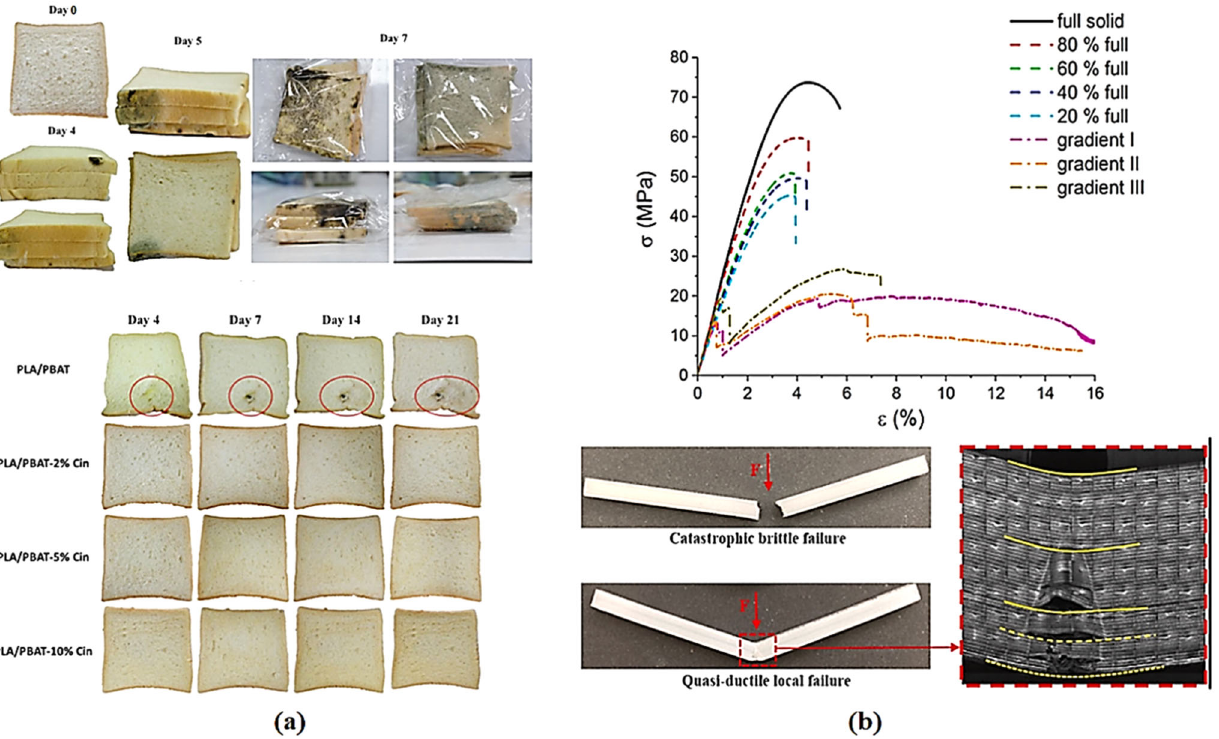
Fig. 18 Forensic engineering of biodegradable polymers. a Appearance of packaged bread stored in (1) PP and (2) PLA and PBAT blend fi lms with different concentrations of transcinnamaldehy, and b stress – strain curves of PLA samples with various porosity and 3D printed design deformed in three-point bending (top). Comparison of failure modes of specimens 174,175